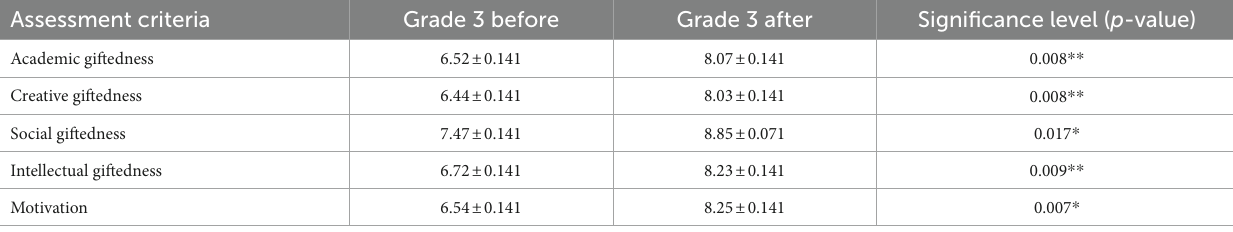
TABLE 3 Calculating class 3 results using student’s t -test. Assessment criteria